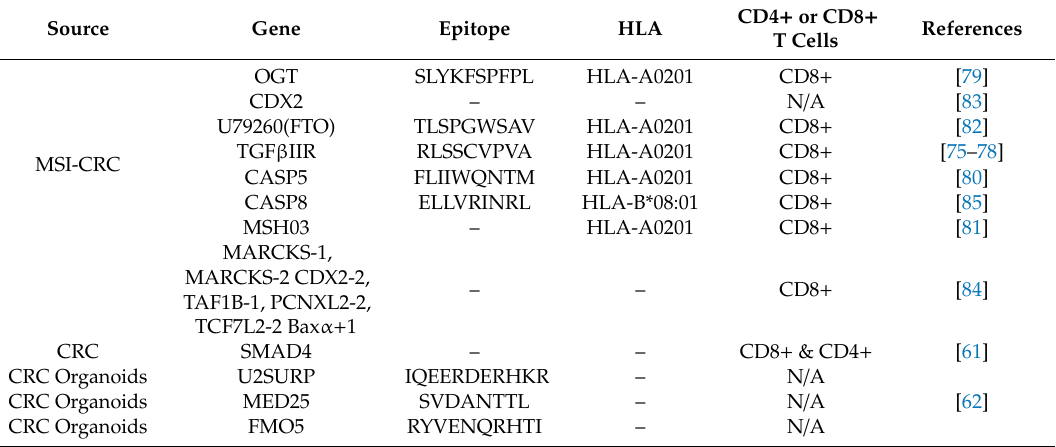
Table 1. List of mutated antigens that were studied in